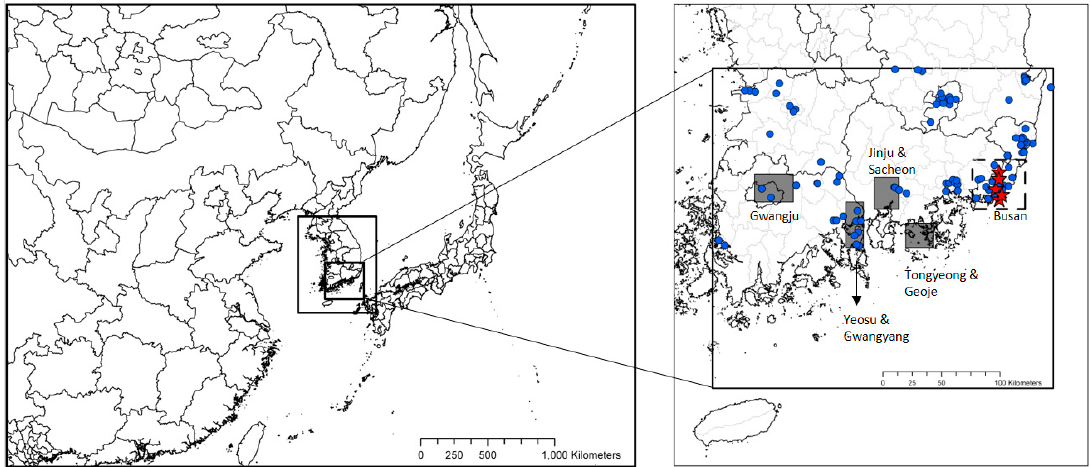
Figure 1. Modeling domains, observation sites, and areas of focused analyses. The left panel depicts 27-, 9-, and 3-km grid modeling domain boundaries (outer, middle, and inner-most boxes of the left panel, respectively). The right panel shows AMS (blue circles) and PAMS (red stars) monitors in the 3-km modeling domain (inner box of the right panel) including the Metro Busan area, represented with the dashed-line box. Gray boxes display areas for focused analyses. AMS: air quality monitoring stations; PAMS: photochemical assessment monitoring stations.